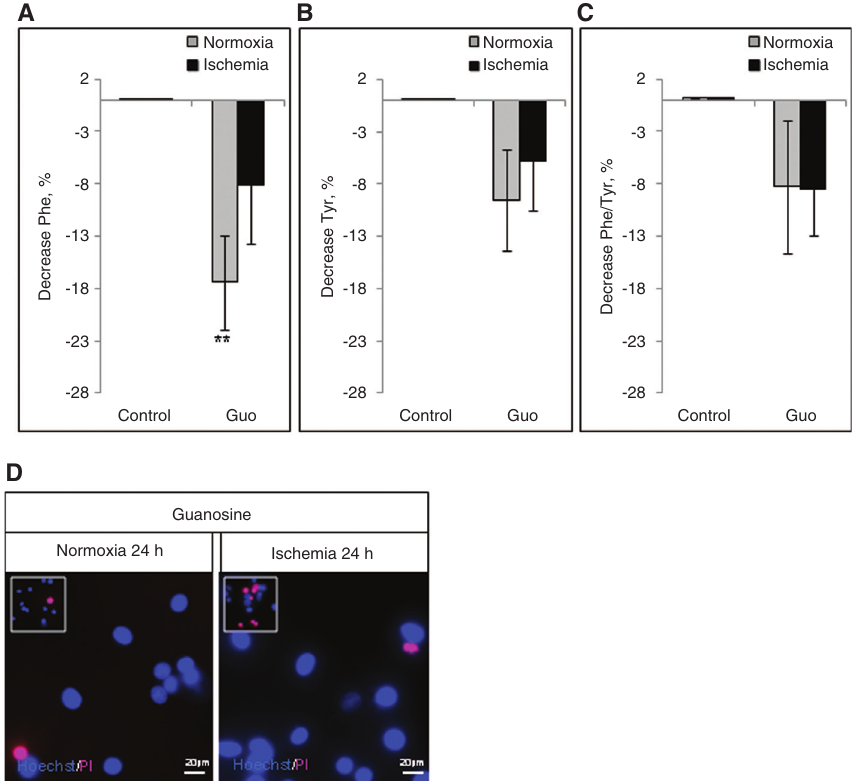
Figure 2 Effect of guanosine on phenylalanine and tyrosine concentrations in normoxic and ischemic PC12 cell cultures. Neuronal PC12 cells were cultivated in normoxic and ischemic conditions in a hypoxia incubator with and without the addition of purine nucleoside guano- sine. Guanosine-treated cell culture supernatants showed a substantial decrease in phenylalanine and also, to a minor extent, in tyrosine concentrations (A and B), accompanied by decreased phenylalanine-to-tyrosine ratios (C). Cell death was studied by double fluorescence analysis of the Hoechst dye (total) and propidium iodide (dead cells) in normoxic and ischemic cell cultures treated with and without guano- sine and reflects its neuroprotective effect (D). Values represent the mean ± SEM, n = 3. Differences were analyzed using unpaired one-tailed t-test: **p <